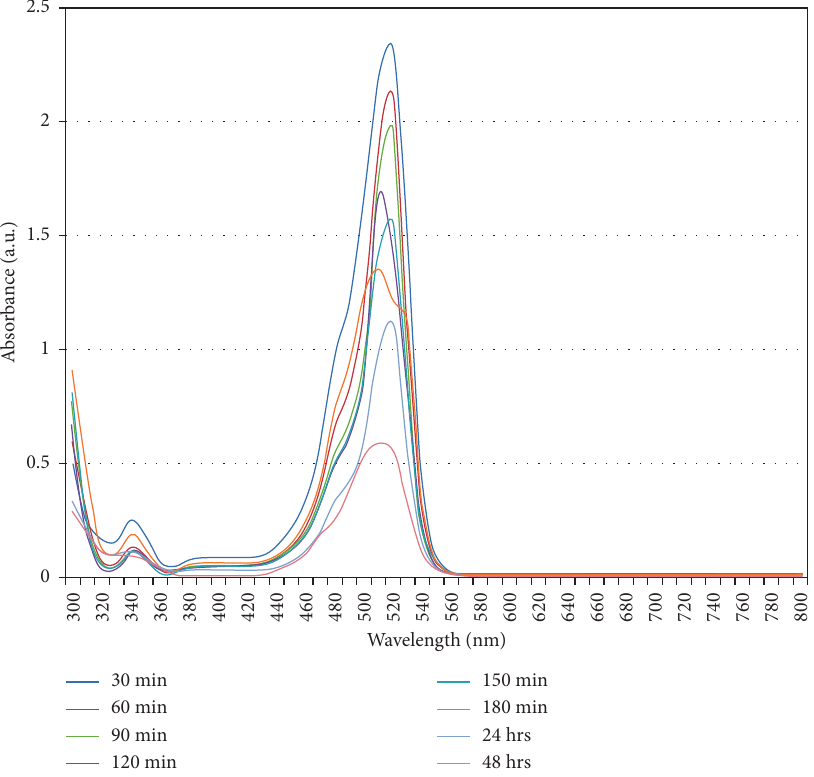
Figure 11: Catalytic degradation of eosin using copper nanoparticles. Y -axis: absorbance, and X -axis: wavelength in